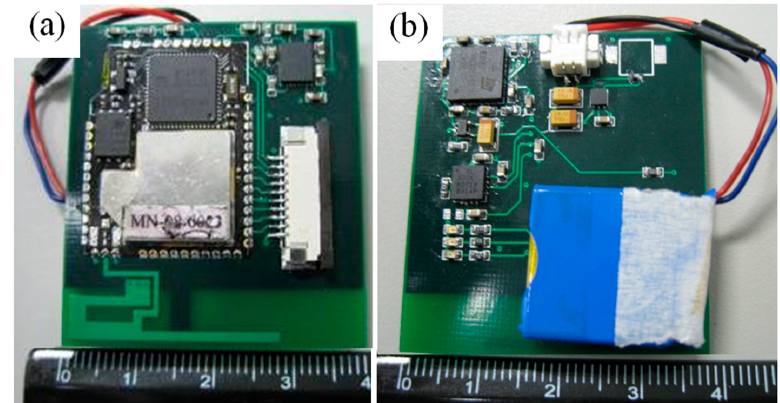
Figure 1. The wearable WSN body motion sensor with inertial sensing node: ( a ) WSN mote; ( b ) accelerometer and gyroscope modules with rechargeable battery.